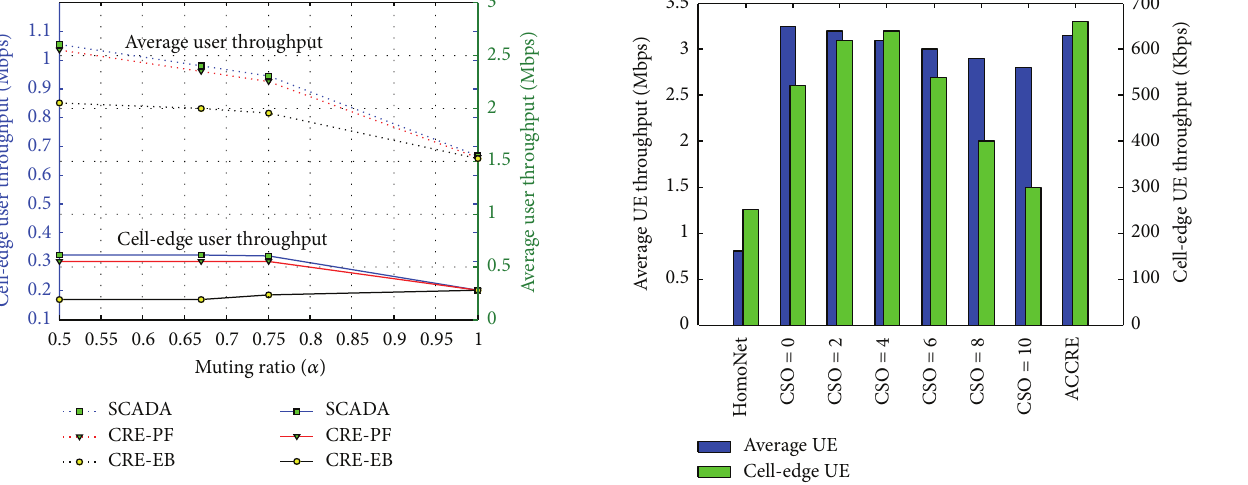
or CSO high low